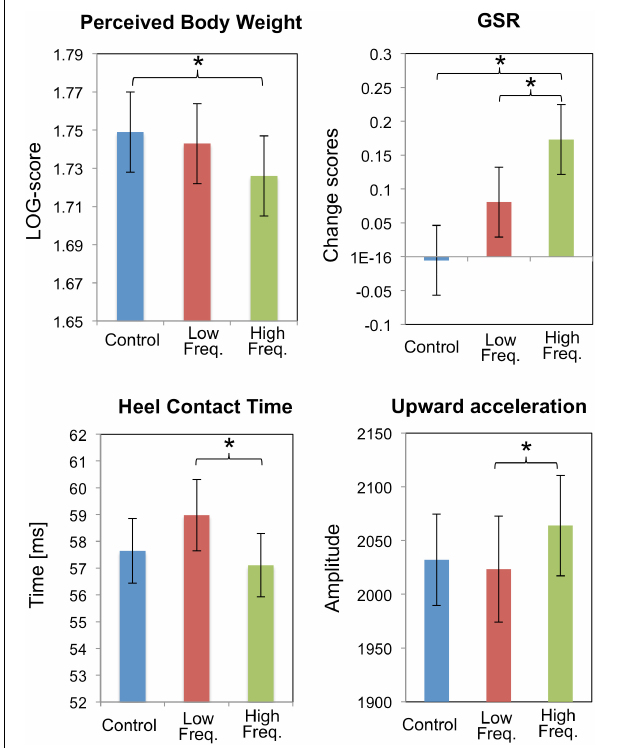
FIGURE 3 | Results from Tajadura-Jiménez et al.’s (2015a) experiment highlighting the consequences of frequency manipulation (normal, low, high) of the sound of footsteps while walking. They explore the effects of this manipulation on perceived body weight, galvanic skin response (GSR), heel contact time (milliseconds) during walking, and acceleration of the foot’s upward movement during walking. All values are mean ± standard error. ∗ Denotes a significant difference between means. [From Figure 4 of Tajadura-Jiménez et al. (2015a). Reproduced with permission of the Association for Computing Machinery in the format Republish in a journal/magazine via Copyright Clearance